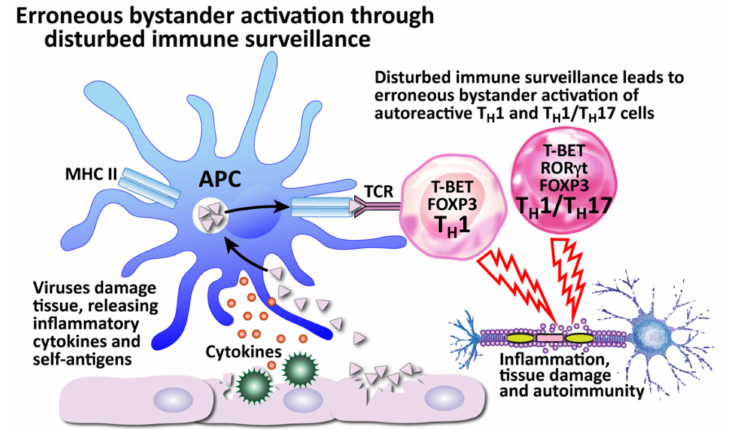
Figure 13. How viruses can induce autoimmunity through erroneous bystander activation by disturbed immune surveillance. The body’s defender cells usually constantly monitor and actively protect the body through immune surveillance, calling upon the proper defensive immune cells when a threat is recognized. However, a disturbance of the immune surveillance can lead to the recruitment of autoreactive Th1 and Th1/Th17 cells instead, which can result in tissue destruction.